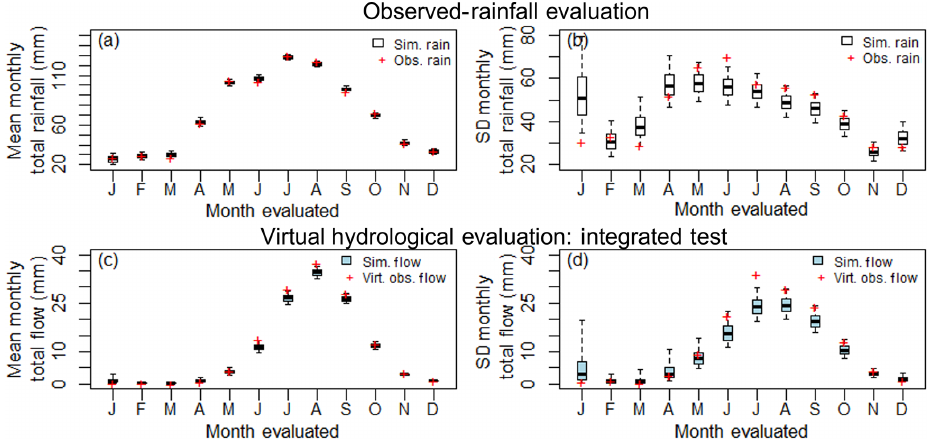
Figure 8. Lobethal, Site 12 (a) observed-rainfall evaluation mean monthly total rainfall, (b) observed-rainfall evaluation standard deviation of monthly total rainfall, (c) virtual hydrological evaluation (integrated test) mean monthly total streamflow, (d) virtual hydrological evaluation (integrated test) standard deviation of monthly total streamflow. Boxplot whiskers indicate the 90% limits of the simulated streamflow or rainfall